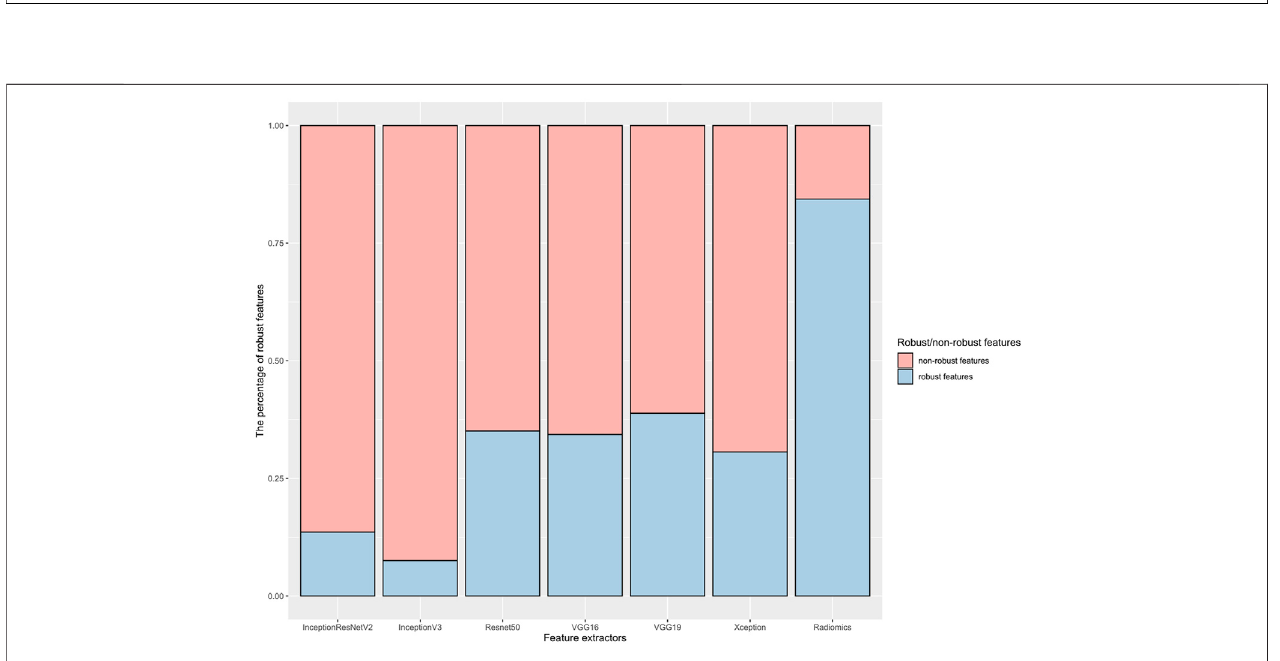
FIGURE 2 | The percentage of robust features against image